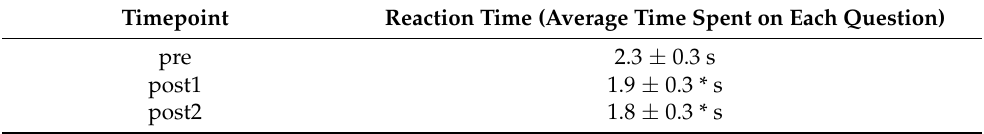
Table 2. Reaction times on the 2-back test (mean ± standard